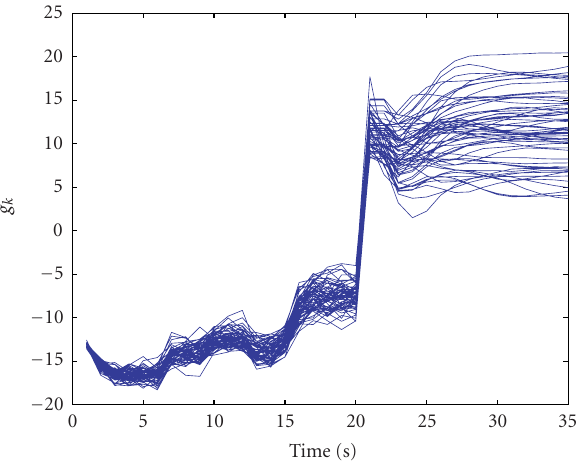
Figure 5: The plot of g k with respect to time for 100 independent runs of an INS/GSP system. g k is the statistics used in the CUSUM algorithm. At time t = 15, the receiver loses three satellites. The cycle slip in channel one occurred at t =